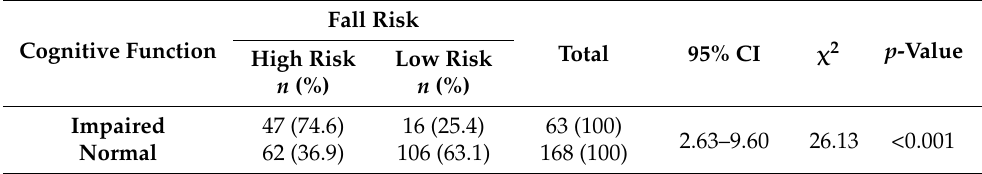
Table 3. Cognitive function and fall